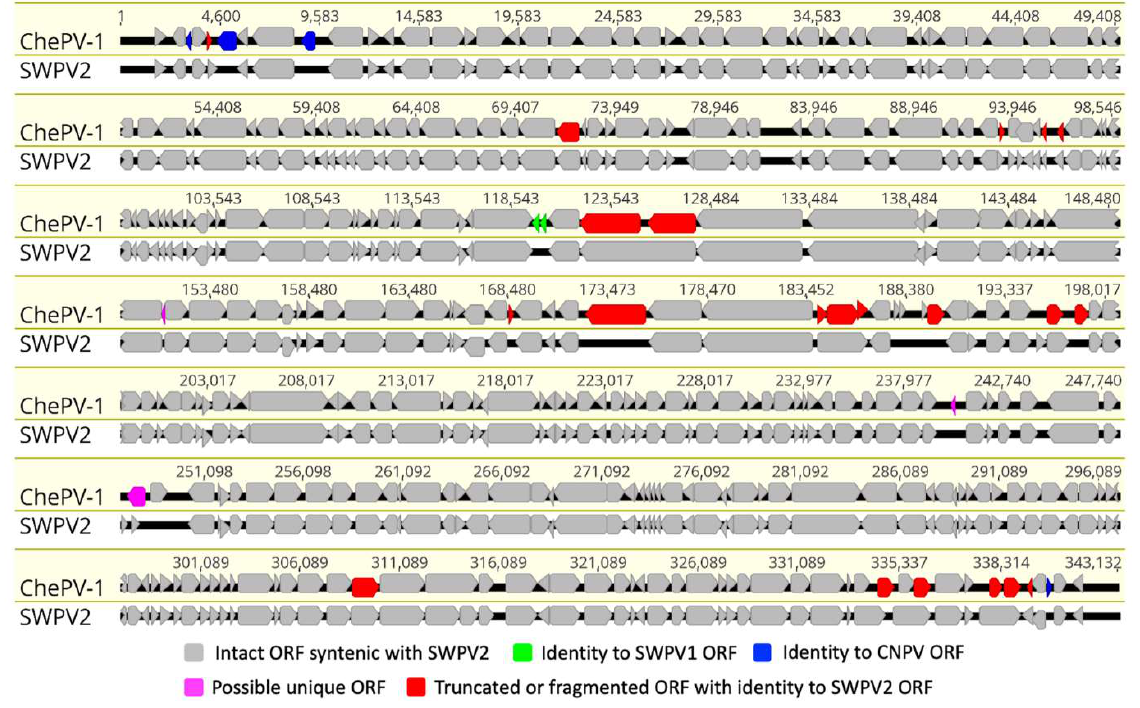
Figure 2. Comparative genomic illustration of the novel Cheloniid poxvirus 1 (ChePV-1) with shearwater poxvirus-2 (SWPV2). Sequence alignment using MAFFT in Geneious (version 10.2.2) was performed to compare open reading frames (ORFs) between cheloniid poxvirus (ChePV-1, GenBank accession no. MT799800) and shearwater poxvirus-2 (SWPV2, GenBank accession no. KX857215). The arrows symbolize genes and open reading frames (ORFs), indicating their direction of transcription. Each gene or ORF is color-coded, as indicated by the color key in the legend.